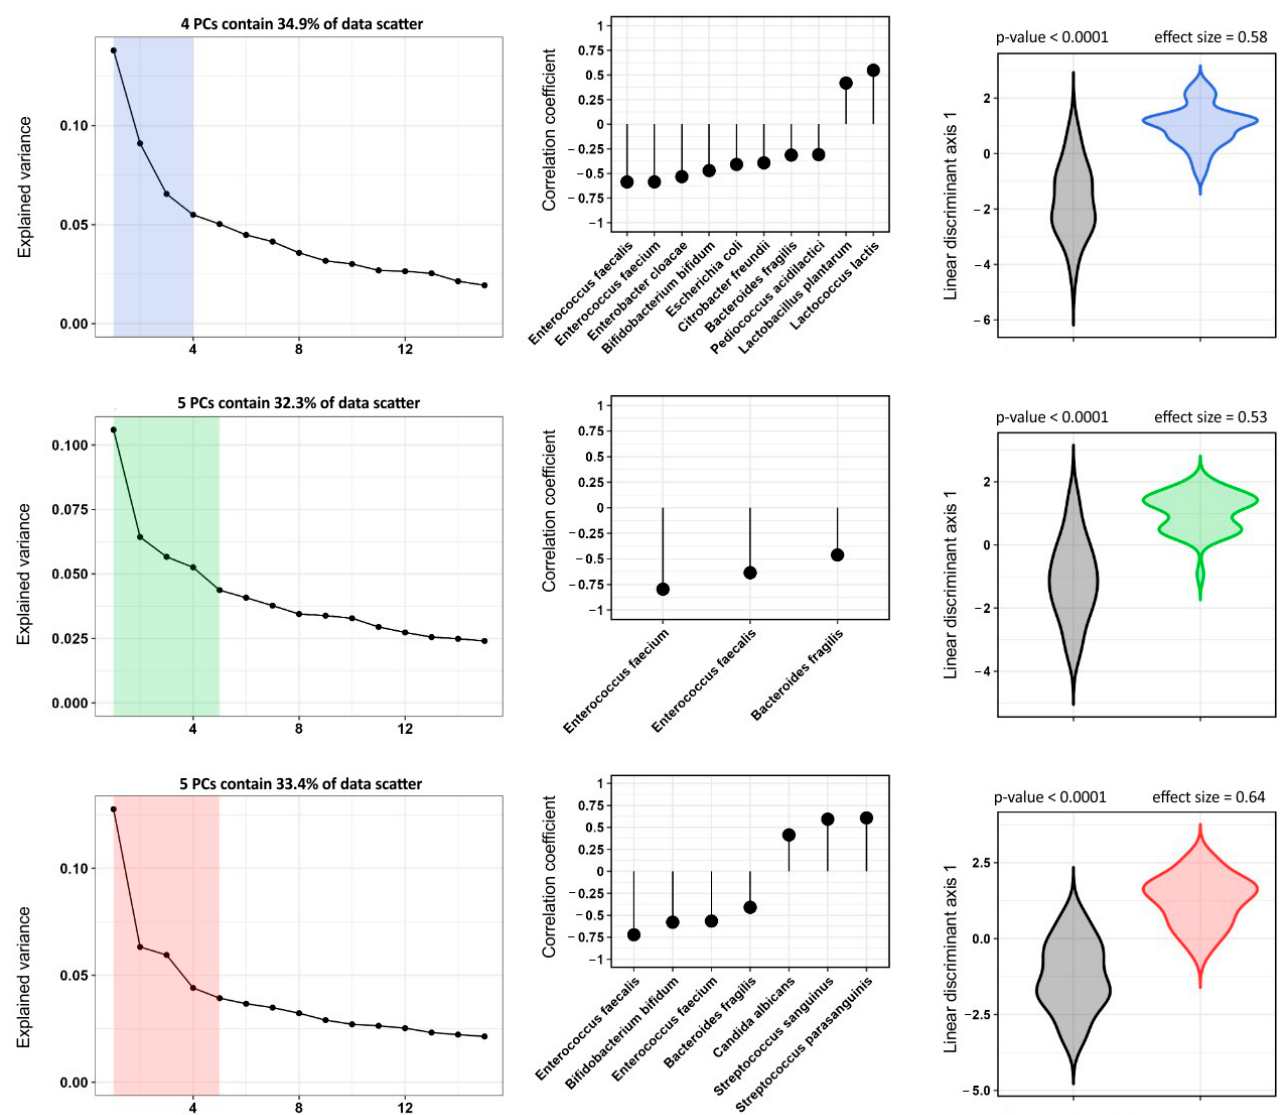
Figure 2. Results of PCA data processing (MALDI-TOF MS), the established correlation between the best discriminant axis and initial indicators, the distribution of the observed group values across the best discriminant axis. The top row of graphs is a comparison of patients of the control group and patients with atherosclerosis, the middle row is a comparison of patients of the control group and patients with HFpEF patients, the bottom row of graphs is a comparison of patients of the control group and patients with HFrEF patients.